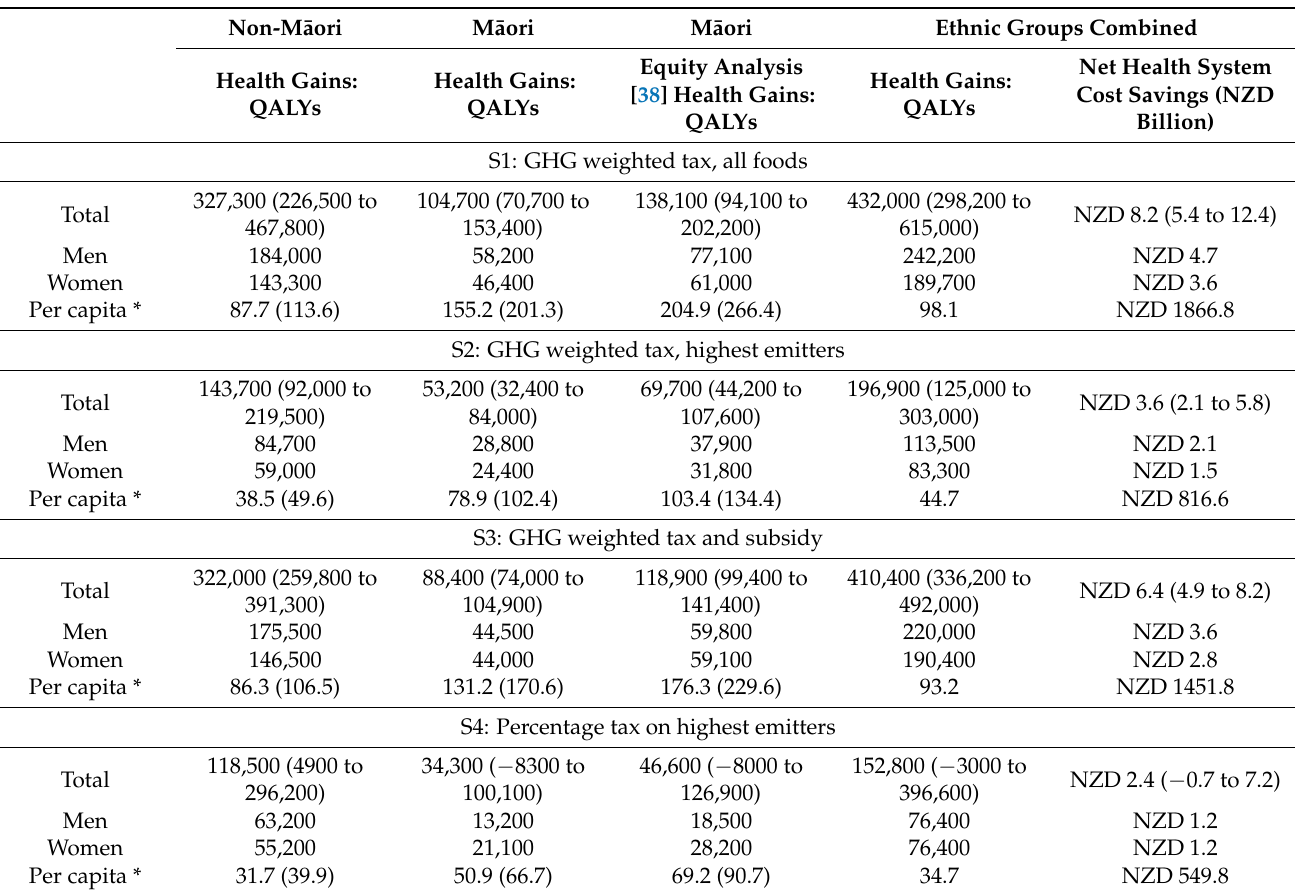
Table 2. Lifetime health impacts (in QALYs) and health system costs for GHG food taxes, for the NZ population alive in 2011 (lifetime horizon) with 3% discount rate. Non-M¯aori M¯aori M¯aori Ethnic Groups Combined Net Health Equity Analysis QALYs